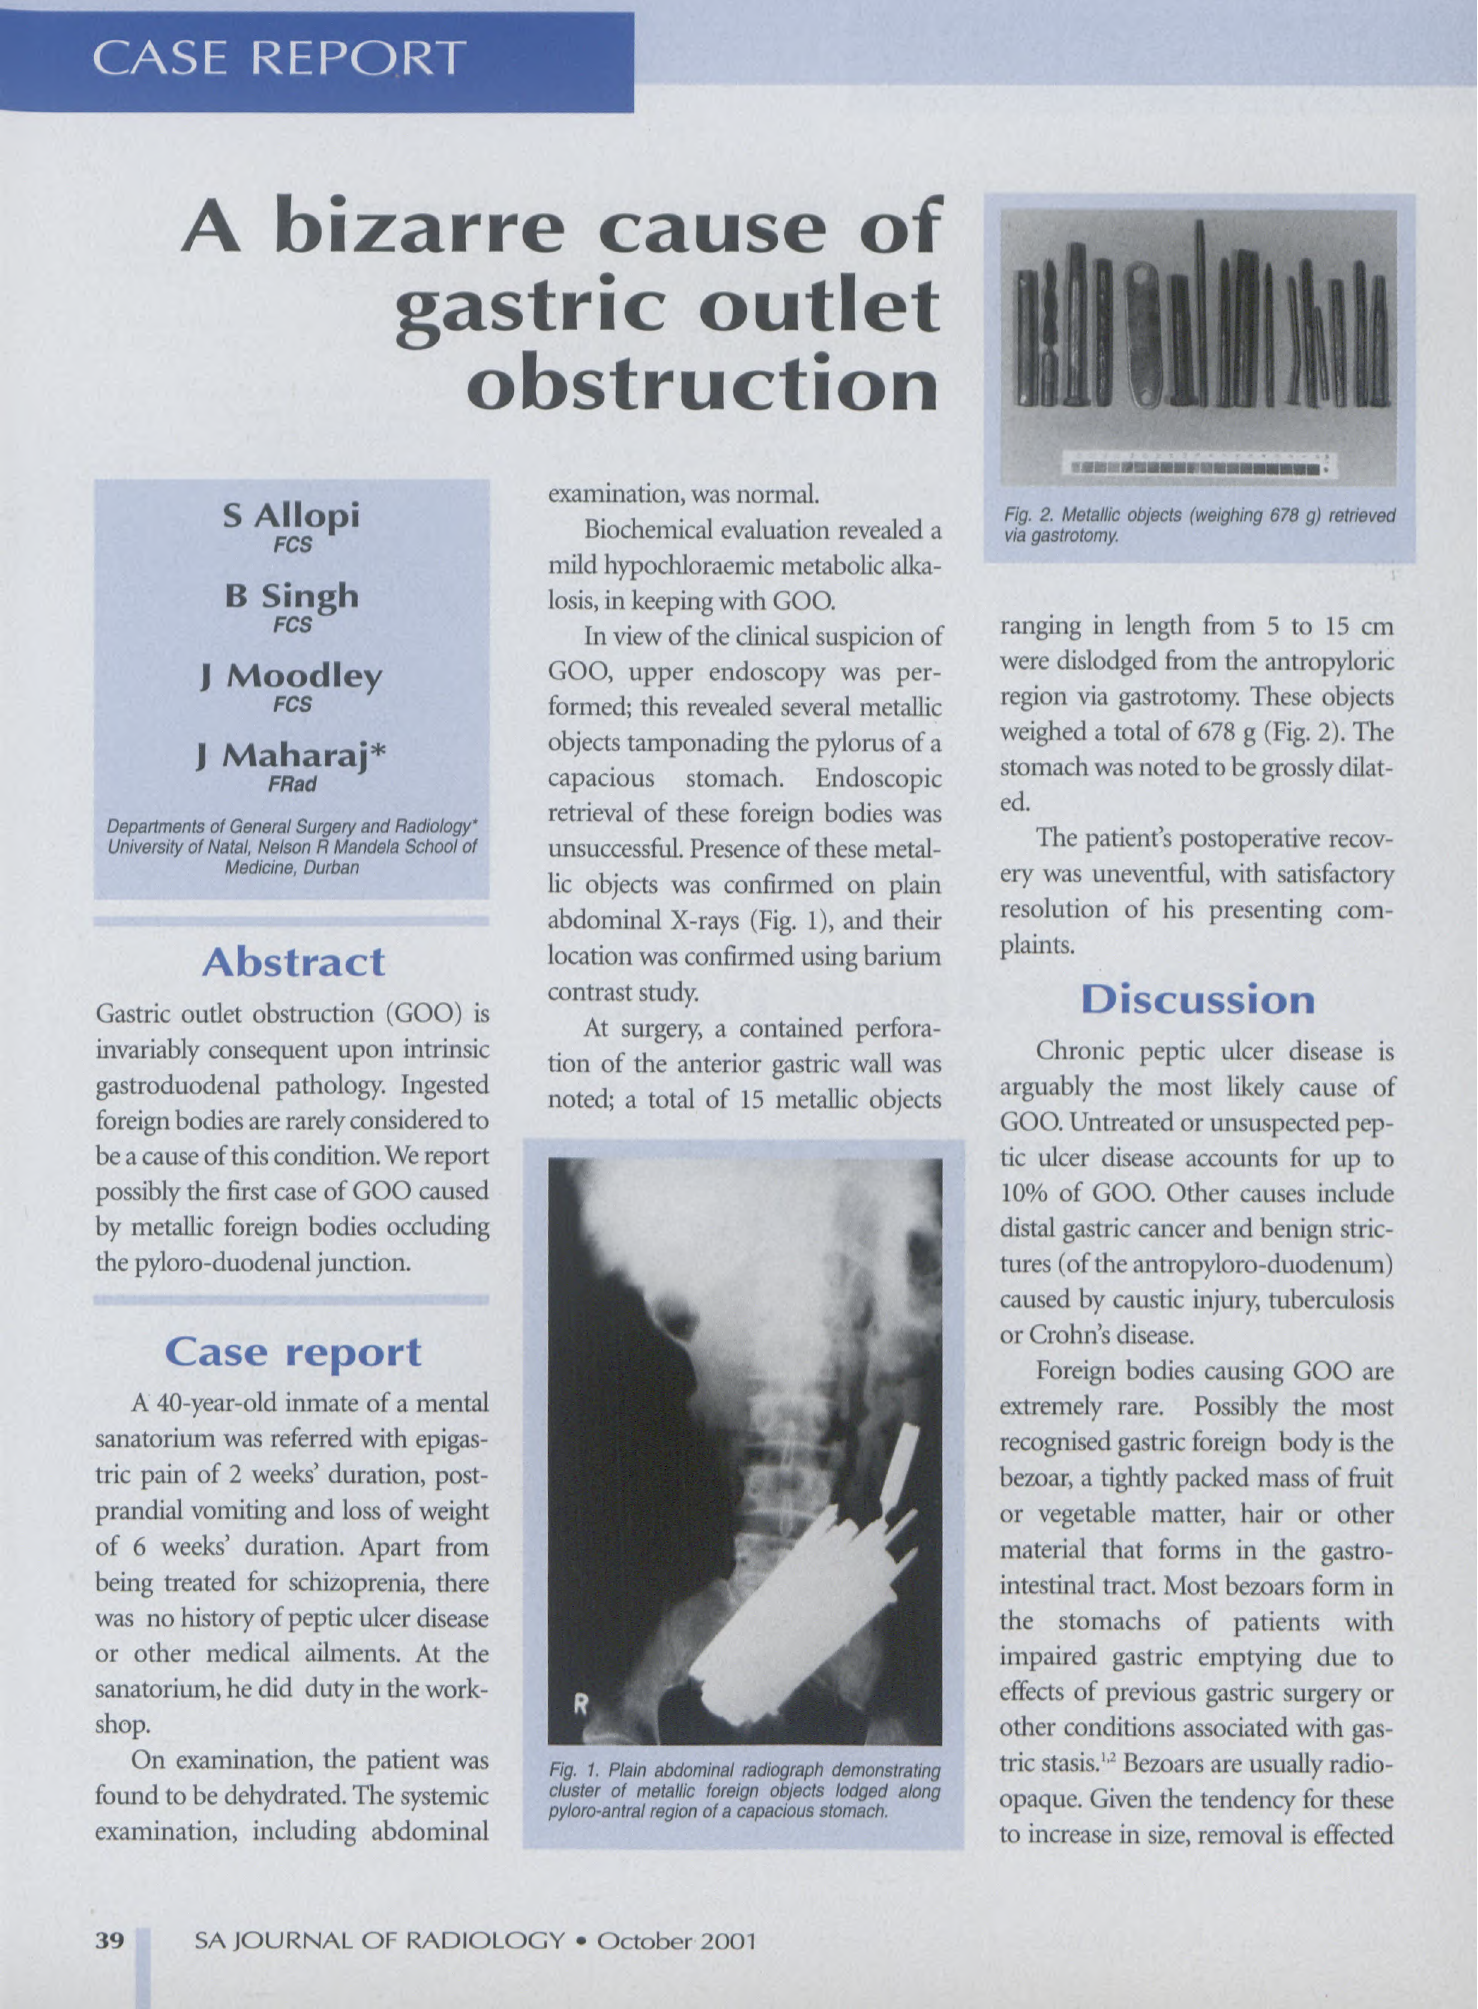
Fig. 1. Plain abdominal radiograph demonstrating cluster of metallic foreign objects lodged along pyloro-antral region of a capacious